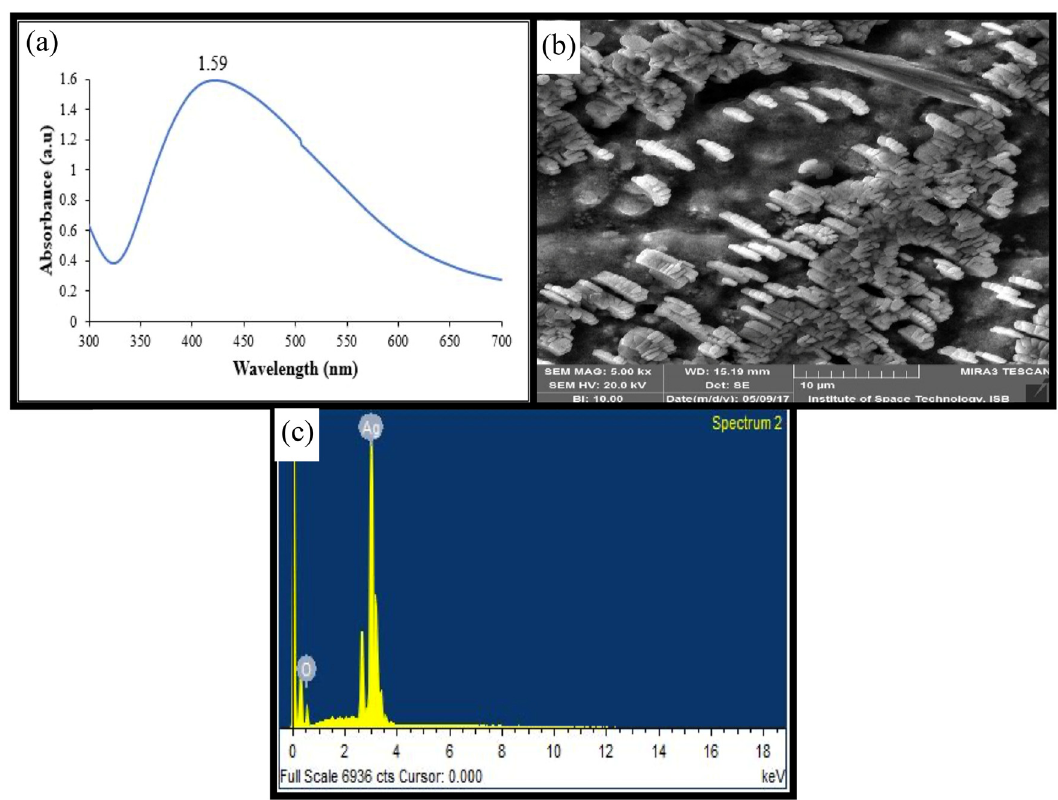
Figure 1: Morphological and optical characterization of bio - fabricated AgNPs: ( a ) UV - visible spectrum, ( b ) SEM image, and ( c ) elemental composition